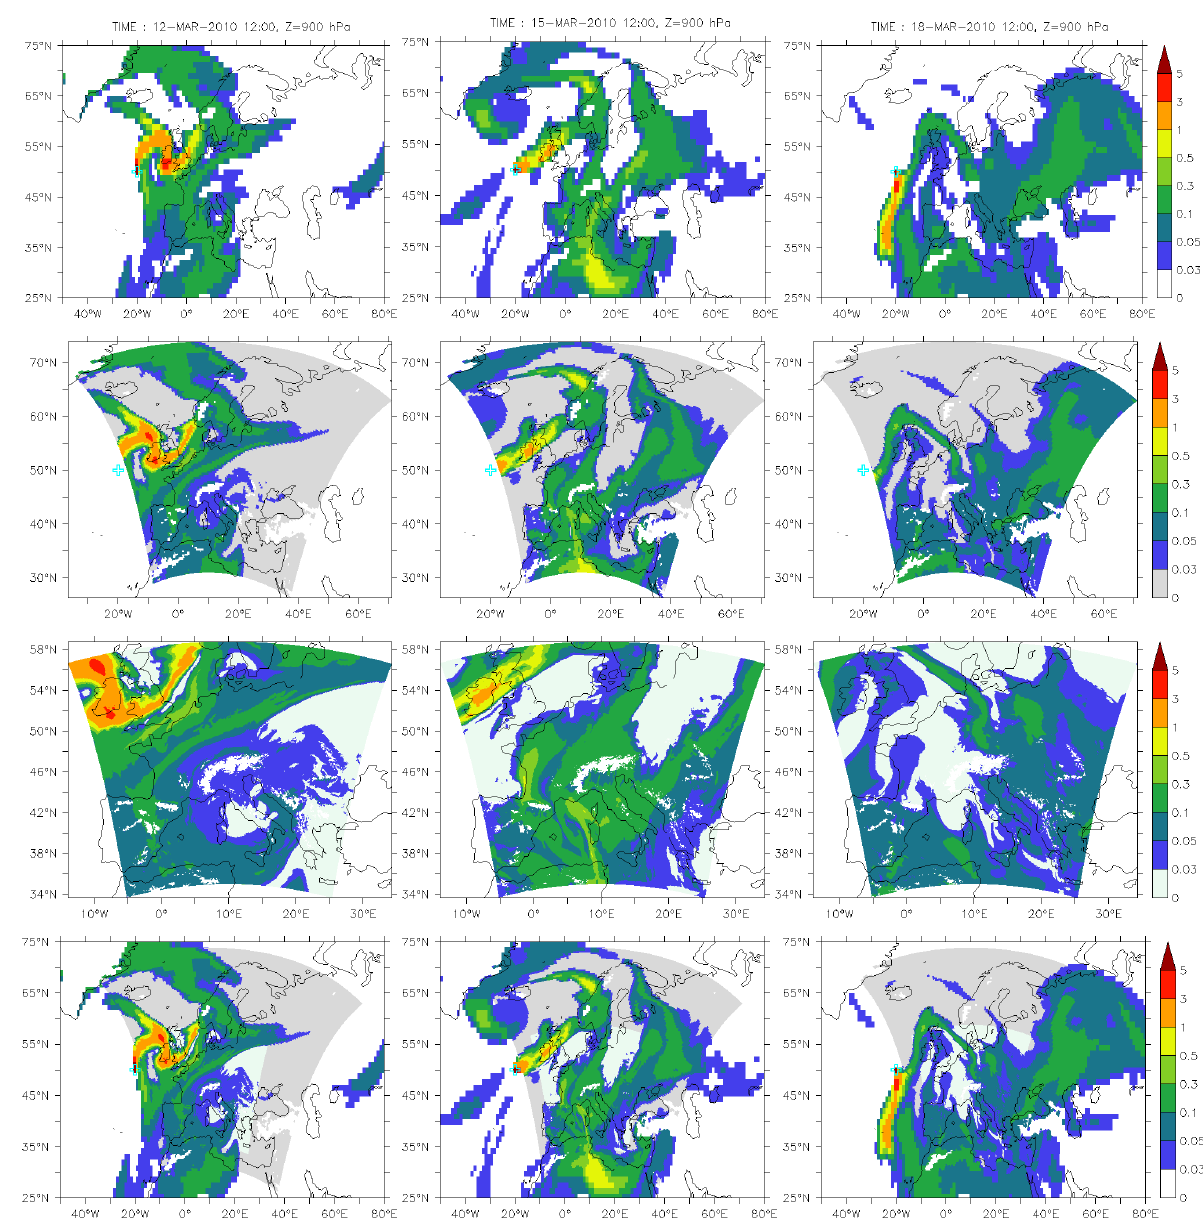
Fig. 7. Horizontal distribution at 900 hPa of the artificial tracer PNT. The location of the emission point is indicated by the light blue plus sign. Results are shown for the 12th, 15th and 18th simulation day at 12:00 UTC (columns). First row: ECHAM5/MESSy, second row COSMO-40/MESSy, third row COSMO-7/MESSy and last row composite of all three model domains.